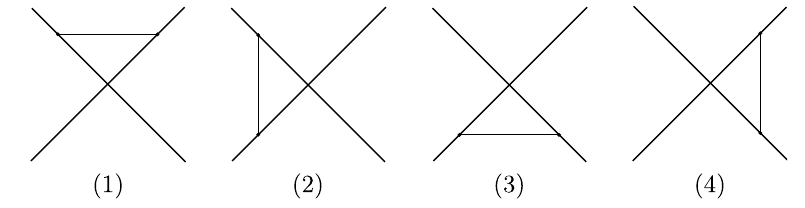
Figure 6 . Diagrams at the one-loop level. The straight line denotes a combination of gluon and scalar